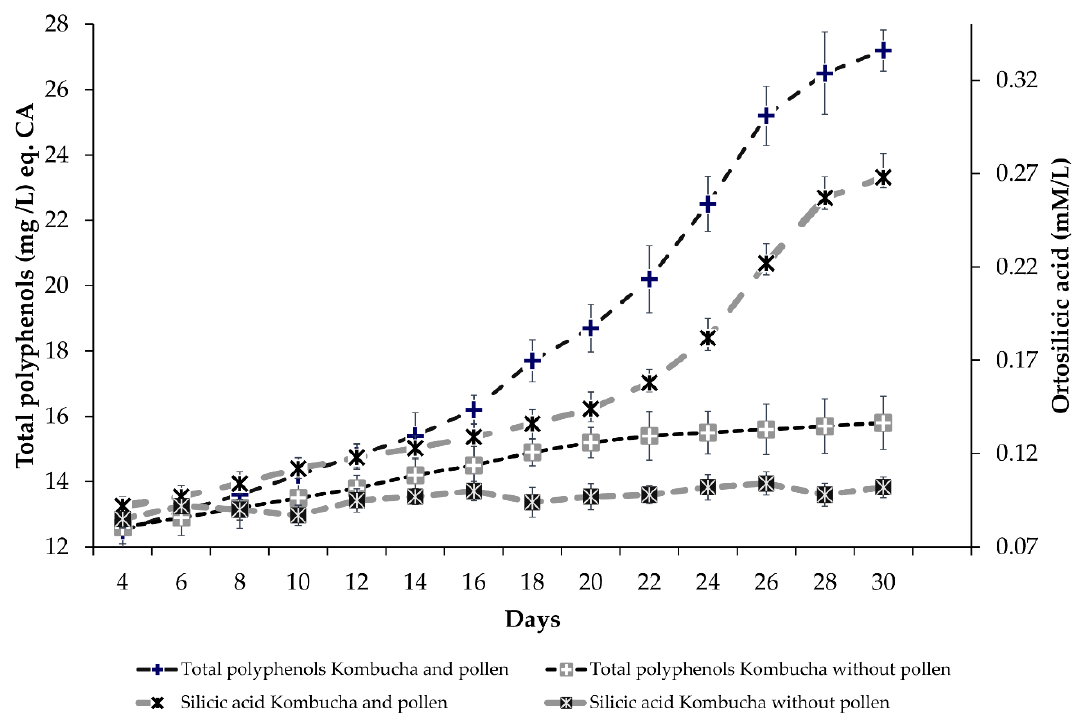
Figure 1. Evolution of soluble silicon and total polyphenols in Kombucha liquid phase, with and without addition of bee collected pollen.